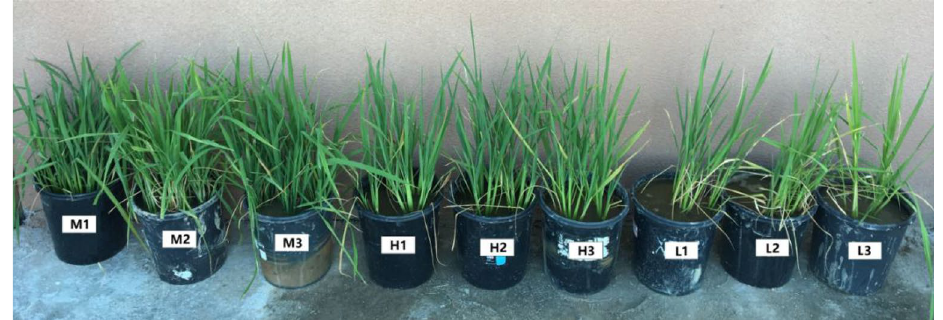
Figure 1. Growth of rice at tillering stage. H1–H3 are soil samples in the mining area with high REE content, M1–M3 are soil samples in the mining area with medium REE content, L1–L3 is soil sample in the non-mining area.